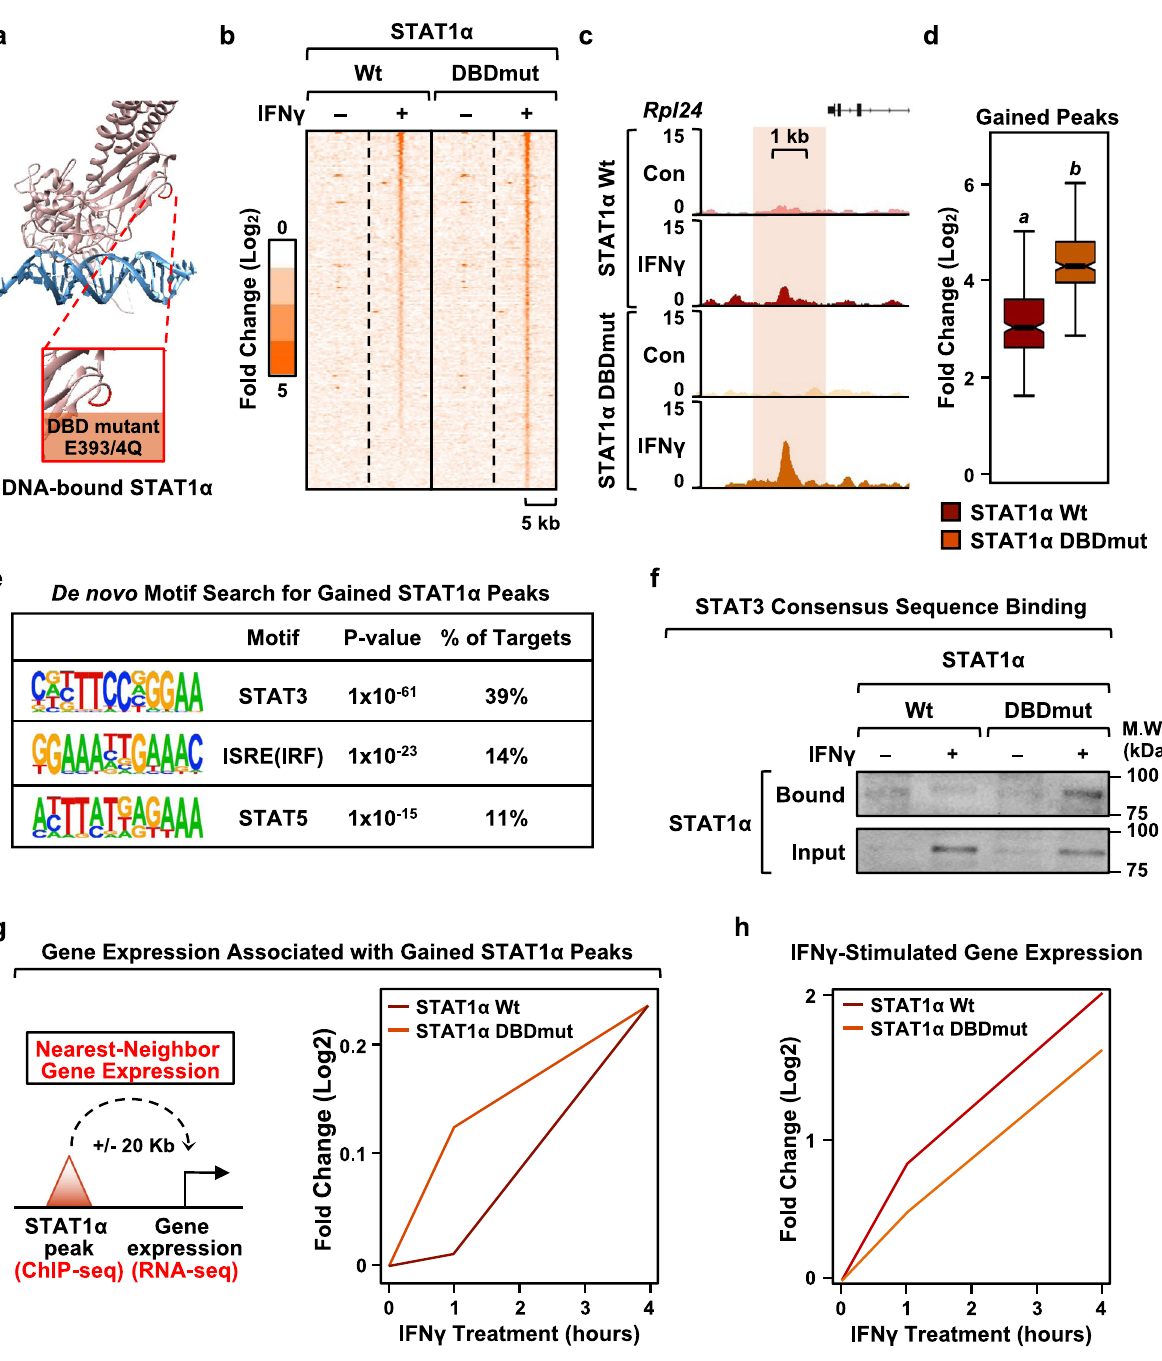
Fig. 5 ADPRylation on its DBD restricts STAT1 α binding to consensus motifs. a Structure of DNA-bound STAT1 α showing sites of ADPRylation on the DBD. STAT1 α is shown in pink and DNA is shown in blue. ADPRylated residues (E393 and E394) are highlighted in red in the expanded view. The structure is from Protein Data Bank (PDB) 1BF5. b Heatmap of ChIP-seq data showing STAT1 α enrichment in the top 50% of ‘ gained ’ STAT1 α peaks in iBMDMs expressing wild-type (Wt) or DBD mutant (DBDmut) STAT1 α with concurrent shRNA-mediated knockdown of endogenous STAT1 α . The cells were treated ± IFN γ for 1 h. ‘ Gained ’ peaks were de fi ned using a 4x MAD cutoff. c , d Browser tracks ( c ) and box plots ( d ) of ChIP-seq data representing ‘ gained ’ STAT1 α peaks in iBMDMs expressing DBDmut compared to iBMDMs expressing Wt STAT1 α ( n = 227 peaks; Wilcoxon Signed-Rank test; p < 2.2 × 10 -16 ). Boxes represent 25 th – 75 th percentile (line at median) with whiskers at 1.5*IQR. e Motifs enriched at gained STAT1 α binding sites (DBDmut relative to Wt STAT1 α ). De novo motif analysis was performed using MEME. The predicted motifs were matched to known motifs using TOMTOM. P-values were generated using default parameters in TOMTOM (see Methods). f Binding of STAT1 α DBDmut to non-consensus motifs. STAT1 α from iBMDMs expressing Wt or DBDmut was incubated with double-stranded DNA oligonucleotides containing a consensus STAT3 binding sequence. Bound material and input were analyzed by immunoblotting for STAT1 α . Uncropped immunoblots are provided as a Source Data fi le. g Gene expression associated with gained STAT1 α peaks. Line plots representing fold change in nearest neighbor gene expression upon IFN γ treatment from RNA-seq in iBMDMs expressing Wt or DBDmut STAT1 α with concurrent shRNA-mediated knockdown of endogenous STAT1 α . h Line plots representing fold change in IFN γ -stimulated gene expression in iBMDMs expressing Wt or DBDmut STAT1 α relative to an untreated control. NATURE COMMUNICATIONS| (2021) 12:3931 |https://doi.org/10.1038/s41467-021-24225-2|www.nature.com/naturecommunications